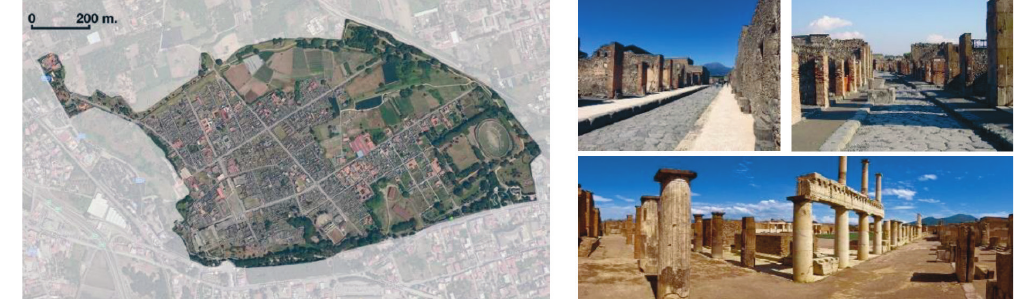
Figure 1. An overview of the archaeological site of